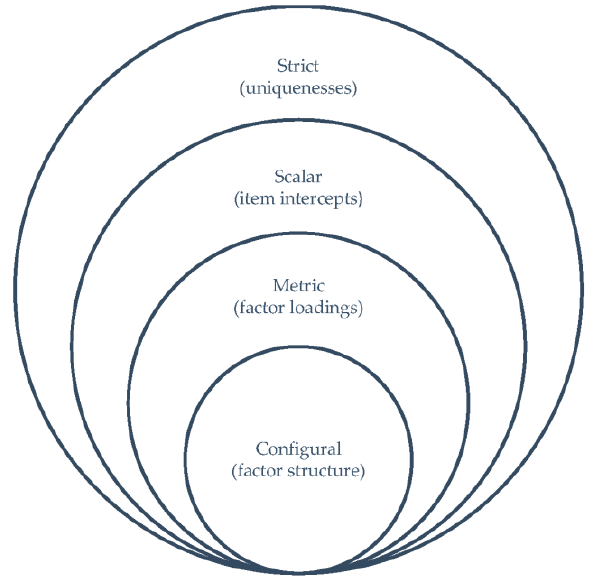
Figure 1. Four models of measurement invariance. The basic configural model concerns verification of uniform factor structure and test items. The metric model is related to factor loadings of individual items and verifies whether they are the same across the tested groups. The scalar invariance model tests if both factor loadings and intercepts are equal across groups. The highest degree of equivalence is represented by the strict invariance model, in which, in addition to the factor loadings and intercepts, there are also residual variances of items.